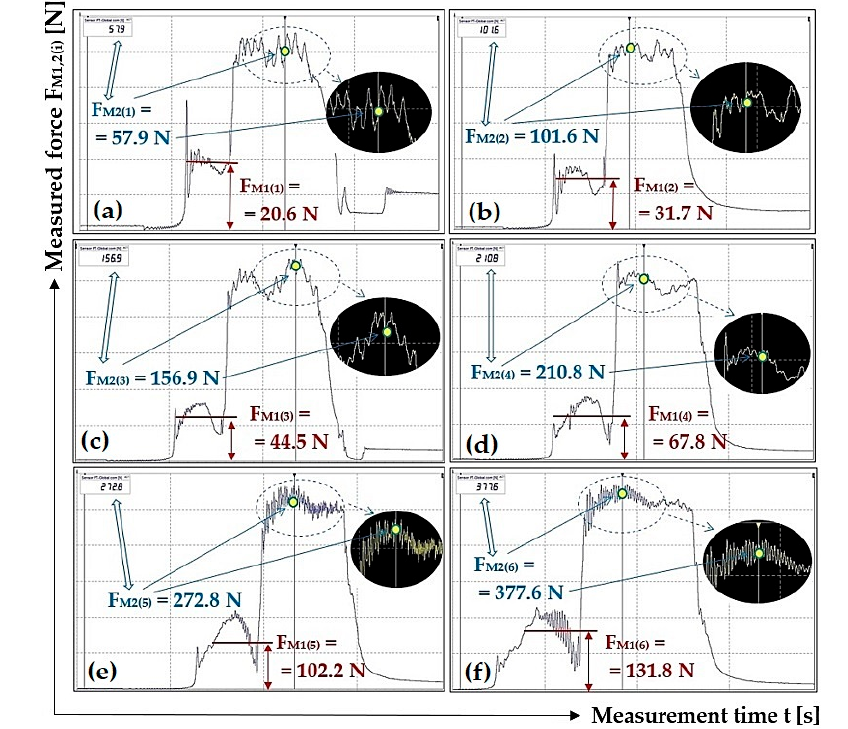
Figure 5. Tensile forces measured using DeweSoft ® software for different load weights at the scraper plough angle of inclination β = 0 deg.